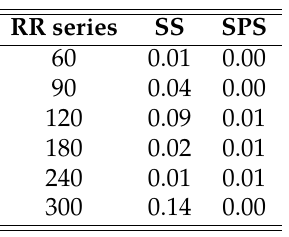
Table 1: Shapiro-Wilk normality test p value.